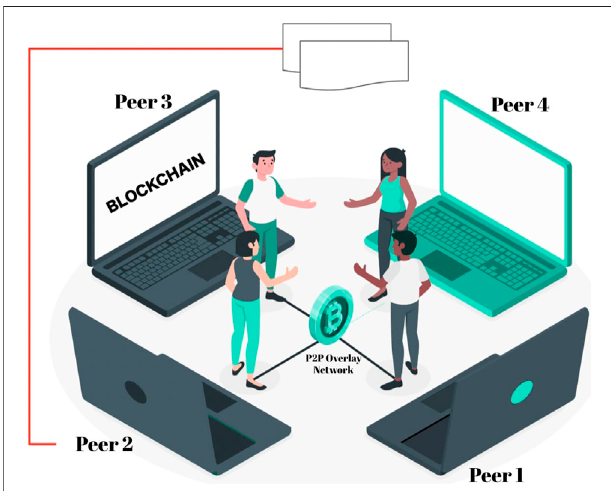
FIGURE 4 | P2P content